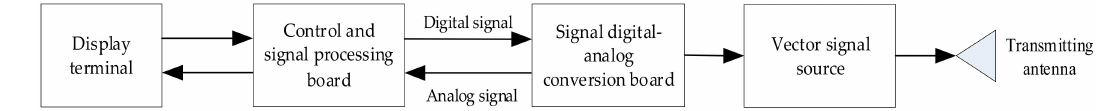
Figure 8. Diagram of the signal transmitting system structure.